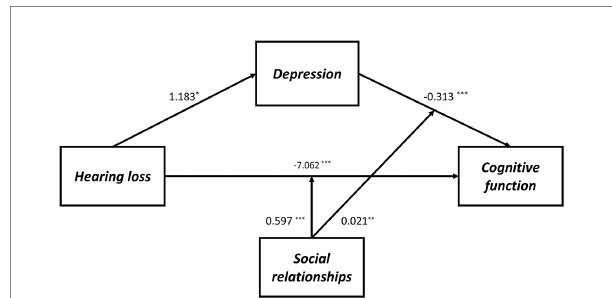
FIGURE 2 The final moderated mediation model: social relationships as moderator of the mediation model of depression between hearing loss and cognitive function (Andrew Hayes’s mediation-moderation Model 15, * p < 0.05; ** p < 0.01; *** p < 0.001). The moderated mediation model was controlled for covariates (age, gender, education level, marital status, lifestyle scores, ADL scores, and physical comorbidities).